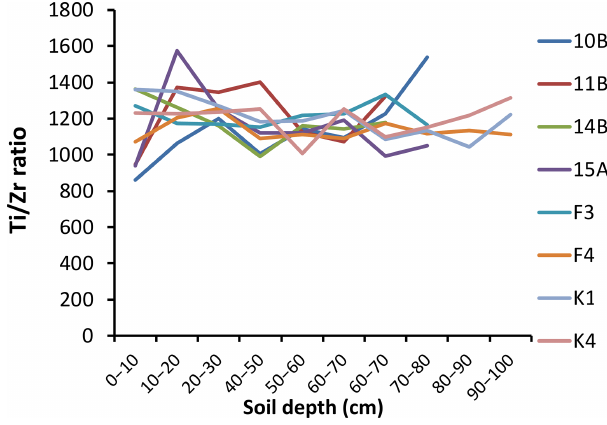
Figure 2. Ratios of titanium (Ti) to zirconium (Zr) by concentration in the soil at Asa (K1, K4, F3, F4) and Flakaliden (10B, 11B, 14B,